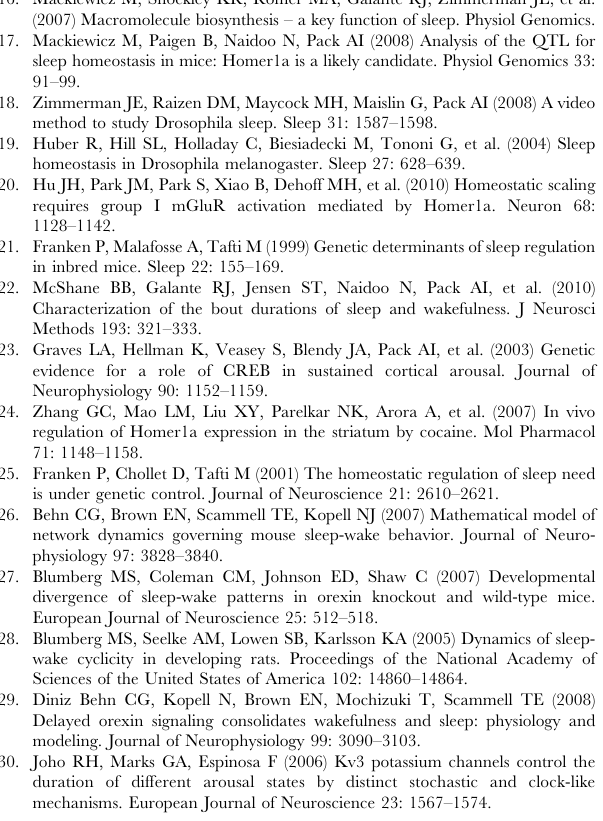
Table S1 Average amount of NREM and NREM bout duration for Homer 1a wildtype, heterozygote and knockout mice measured in 2 hour time periods. Values are given for the average plus/minus standard deviation. Values significantly different from